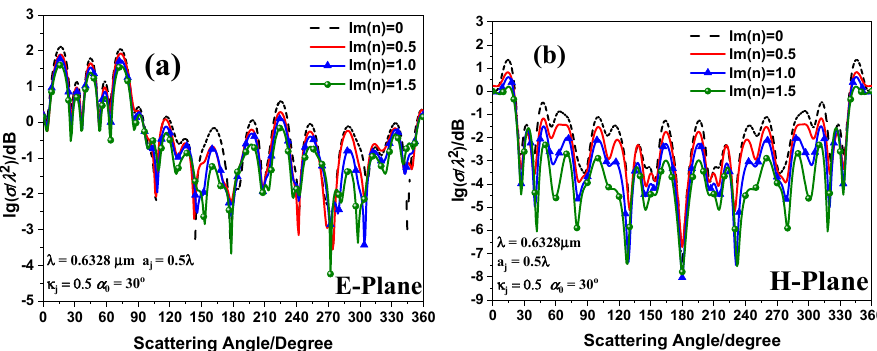
Figure 11. Angular distributions of normalized RCS with varying chiral spheres loss versus scatter-